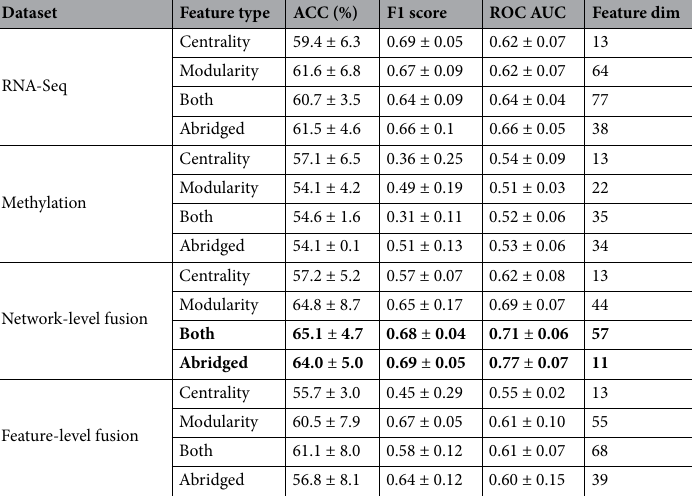
Table 2. Results of DNN on TARGET dataset. Significant values are in bold.